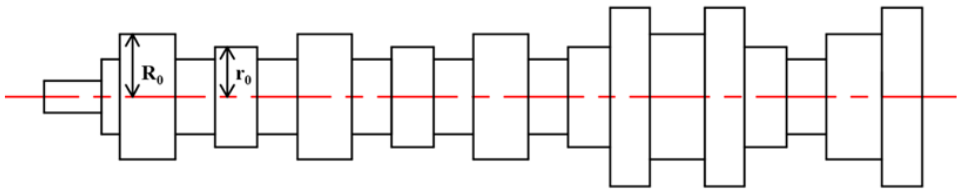
Figure 4. Structure of Calibration part.